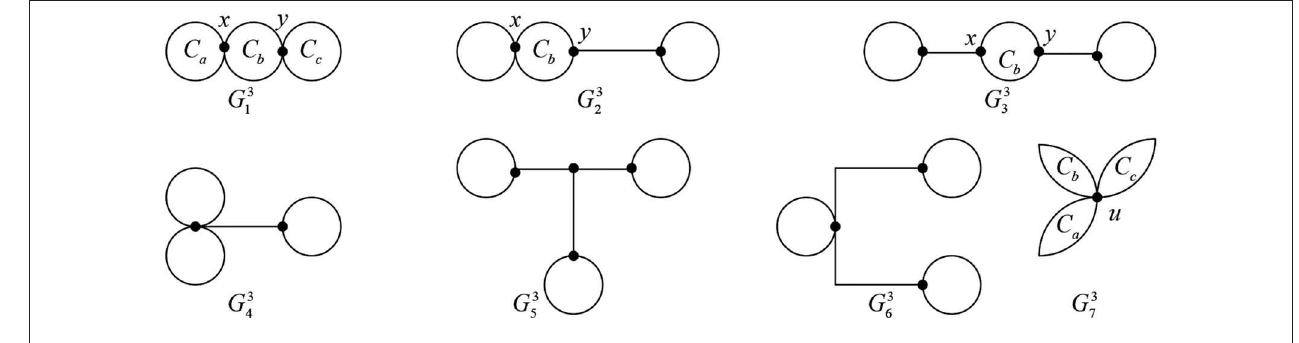
FIGURE 1 | The graphs G 3 i ( i